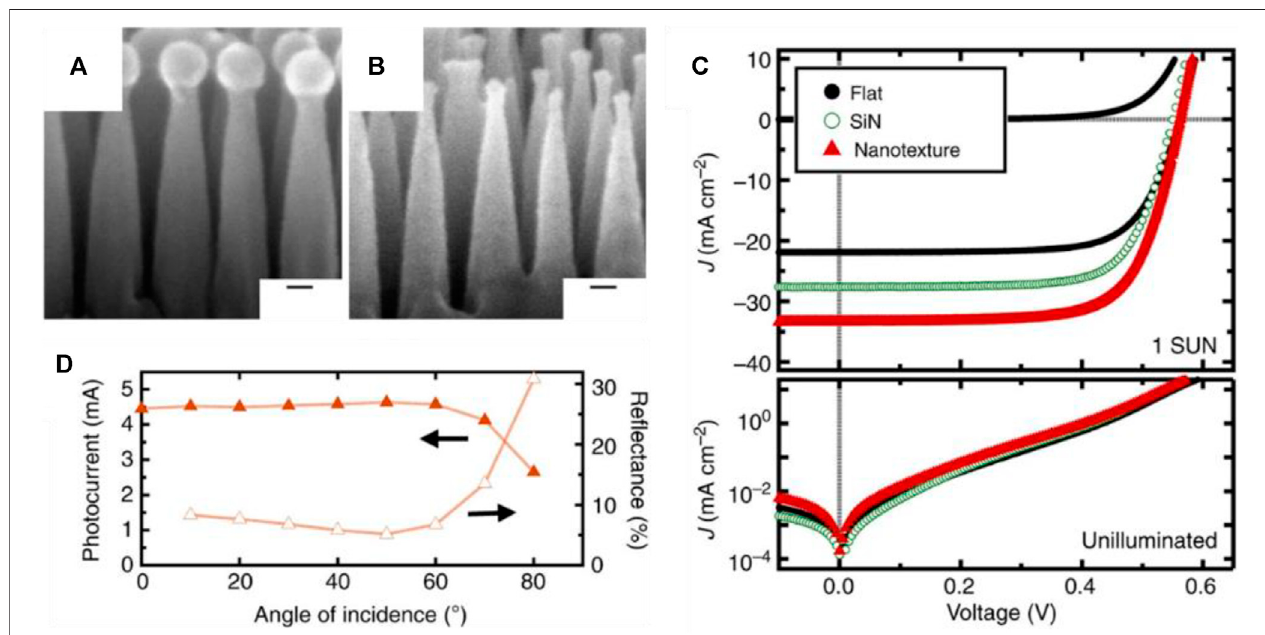
FIGURE 12 | 70 ° -tilted SEM images of nanotextures (A) before and (B) after removal of Alo x nanodots; (C) Illuminated (1 SUN) and unilluminated current – voltage (J – V) characteristics of fl at silicon solar cell (black) and similar cells coated with an silicon nitride antire fl ection coating of 80 nm (green open circles) and a surface nanotexturedusingtheBCPtemplate(red);d)Angulardependence ofdevicephotocurrent(solidredtriangles)andre fl ectance(redopentriangles)whenilluminated with 632-nm light. Left and right arrows refer plotted data to the appropriate horizontal axes. Reproduced with permission from ref (Rahman et al.,